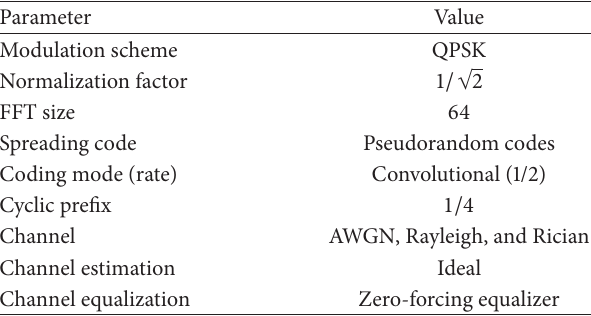
Table 1: Simulation parameters.